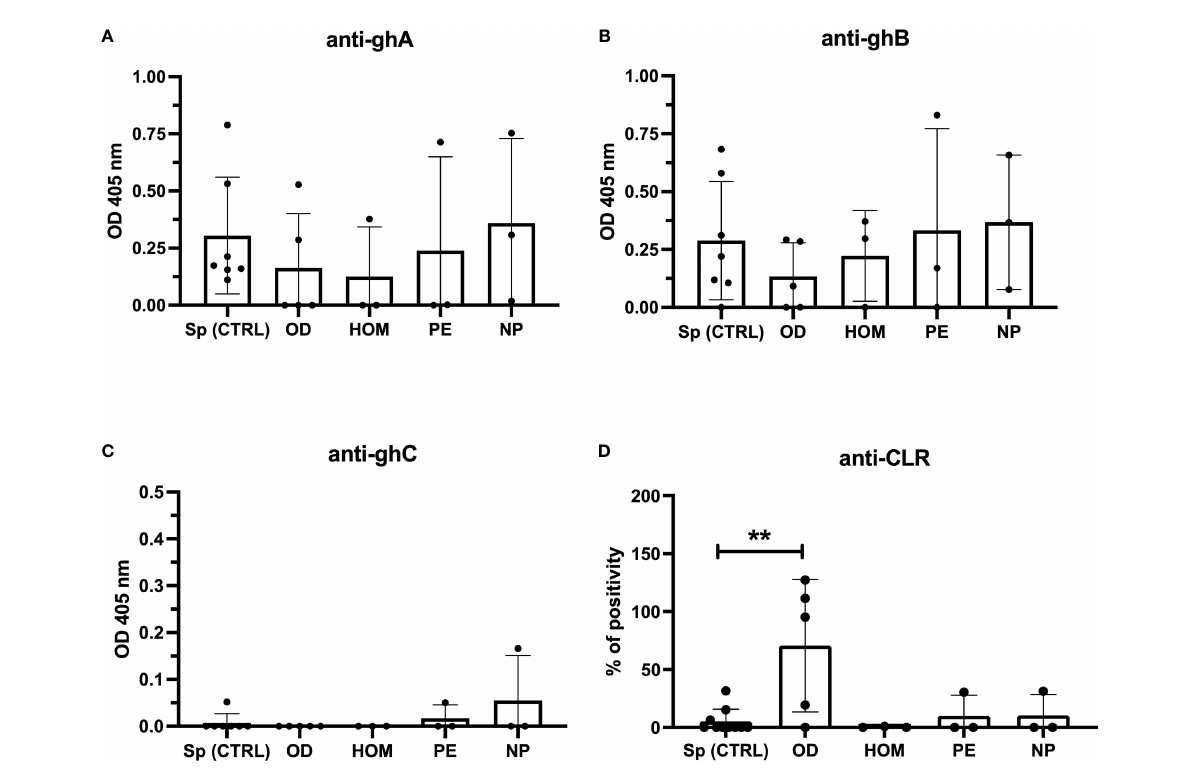
FIGURE 7 Anti-C1q speci fi c to C1q globular heads and CLR in Sp CTRL, OD, HOM, PE pregnancies and NP women. Anti-C1q were characterized for the speci fi city of recognized C1q fragments by ELISA. The recombinant globular head regions of the A, B, and C chains (ghA, ghB, and ghC, respectively) (A – C) and the CLR (D) were coated on microtiter wells. Patient sera were incubated at a dilution of 1:25-1:50 and the detection of anti-C1q antibodies was performed using an anti-human IgG AP-conjugate. Only sera showing anti-C1q levels higher than the cut-off were tested. OD subjects contained higher levels of anti-CLR compared to Sp pregnant women. (**p < 0.01,